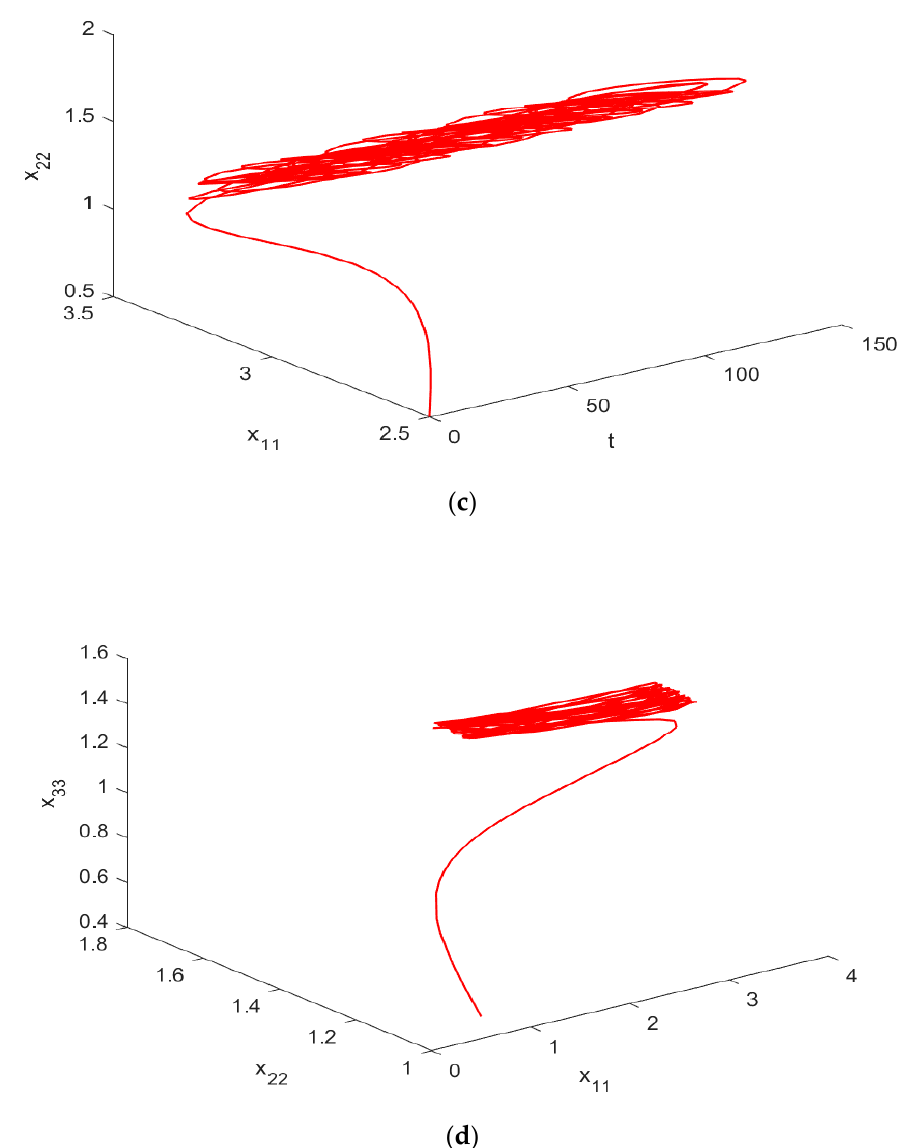
x x − , 3D graphs and initial values are ( a ) (4.0, 2.5), ( b ) Figure 7. The state trajectory of x 11 − x 22 , 3D graphs and initial values are ( a ) ( 4.0,2.5 ) , ( b ) ( 1.0,0.5 ) , Figure 7. The state trajectory of 11 22 ( c ) ( 0.0,2.5,0.5 ) , and ( d ) ( 0.5,1.0,0.5 ) , (1.0, 0.5), ( c ) (0.0, 2.5, 0.5), and ( d ) (0.5,1.0,0.5), respectively.